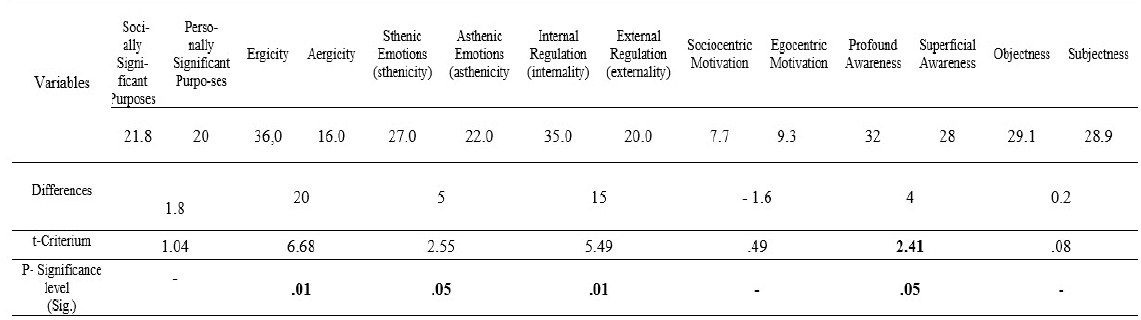
Table 1. Comparative analysis of average values of variables for respondents with a high level of persistence